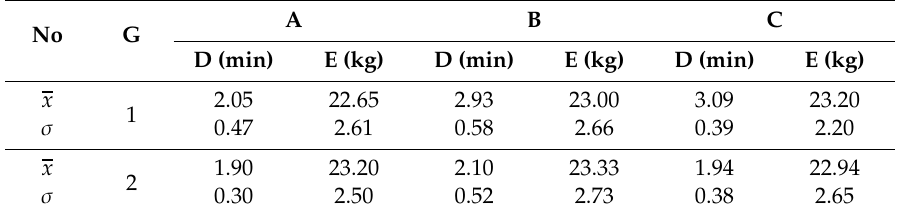
Table 2. Values obtained from measurements.